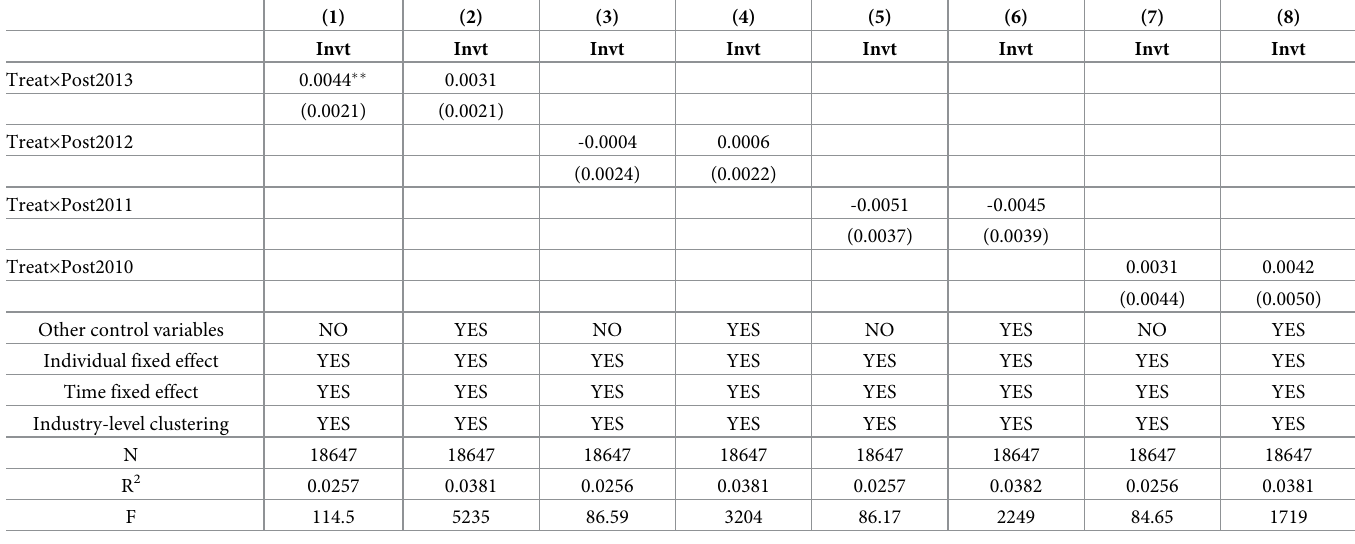
Table 5. Test results of early policy intervention